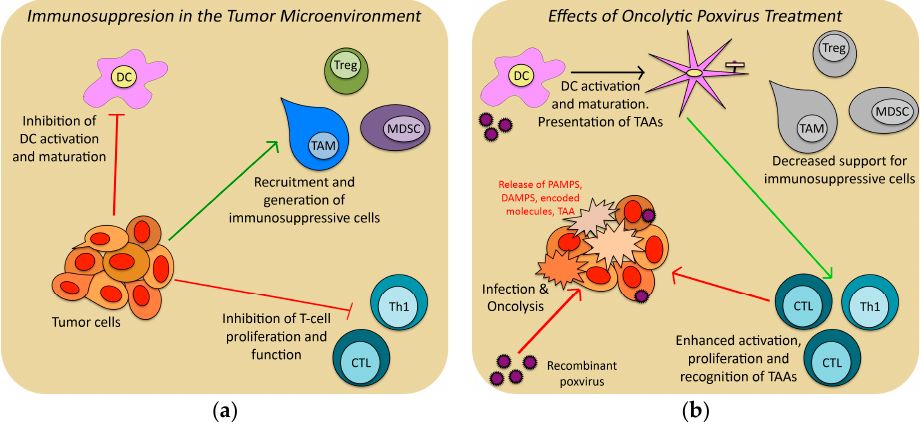
Figure 1. Schematic diagram showing how recombinant oncolytic viruses (OV) therapy can overcome the immunosuppressive effects of the Tumor Microenvironment (TME): ( a ) Tumor cell secretion of a variety of cytokines and other factors can inhibit productive immune response by dendritic cells (DC), cytolytic T-cells (CTL) and type-1 helper T-cells (TH1) and generate protective immunosuppressive cell populations such as tumor-associated macrophages (TAM), myeloid-derived suppressor cells (MDSC) and regulatory T-cells (Treg); ( b ) Intratumoral treatment with OV therapy can overcome the immunosuppressive TME by lysing tumor cells (releasing inflammatory signals), expressing immunostimulatory molecules within the TME (reversing the inhibition by tumor cells and removing the stimuli for immunosuppressive cells), and over-expressing tumor-associated-antigens (TAAs) for DC uptake and T-cell activation.